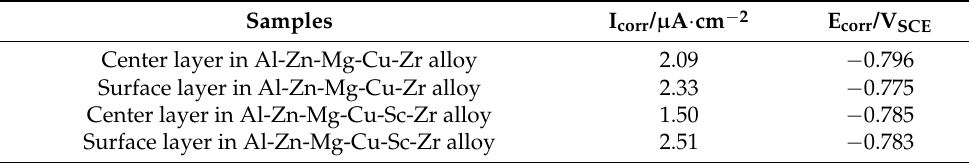
Figure 10. Potentiodynamic polarization curves of the central and surface layer samples of Al-Zn- Mg-Cu alloys in the natural aging condition. Table 4. Evaluated results of electrochemical parameters using Tafel slope